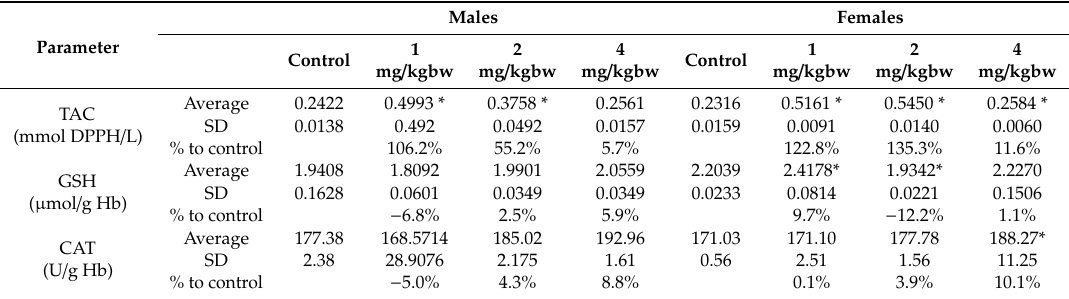
Table 1. Markers at 28 days after exposure to di ff erent concentrations of